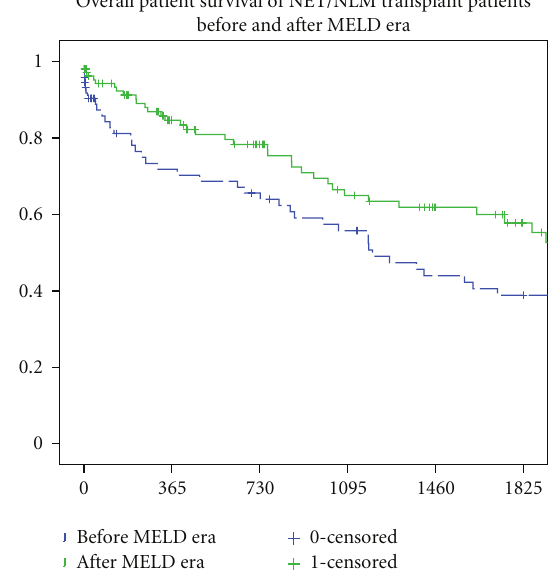
Figure 2: Overall patient survival of NET/NLM transplant patients in pre- and post-MELD